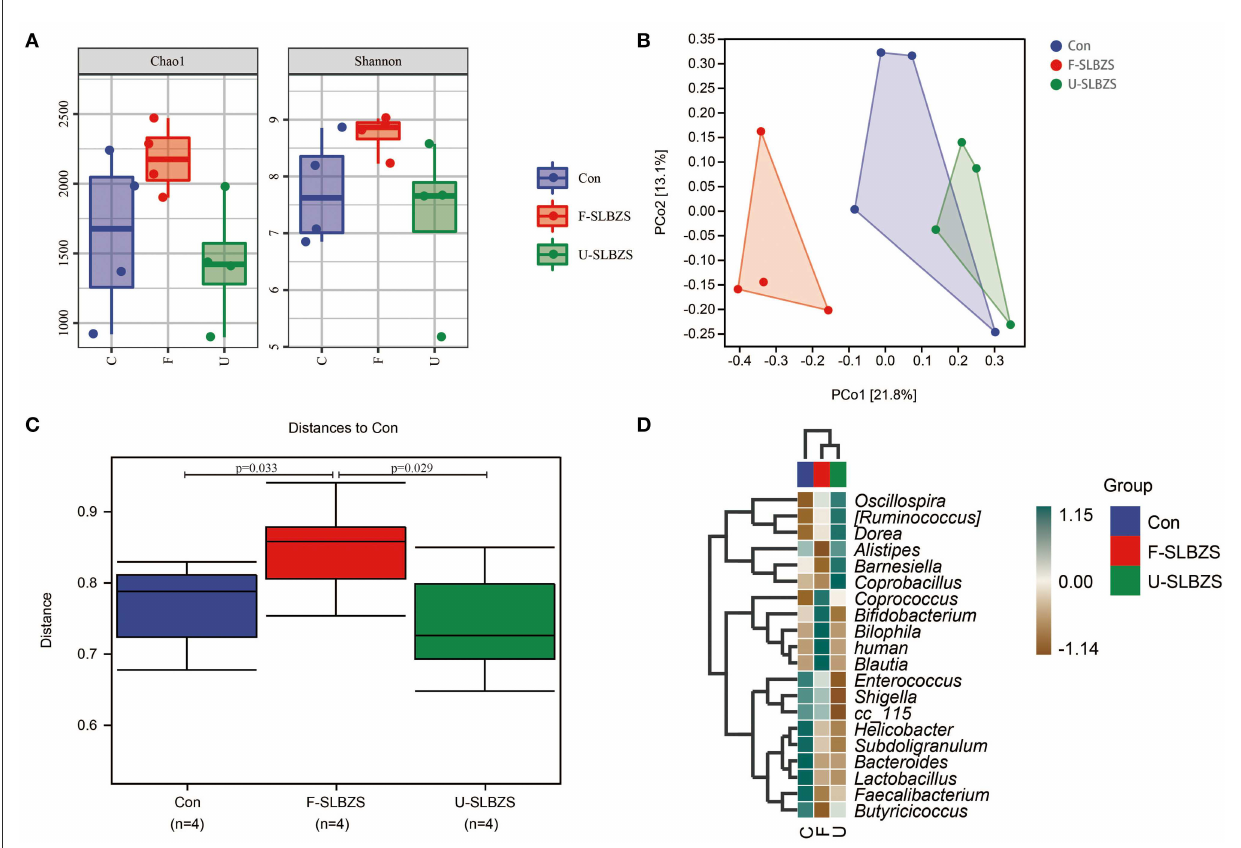
FIGURE7 Fermented alters the structure of the gut microbiota in broilers. (A) Alpha analysis, including Chao1 and Shannon. (B) Principal Co-ordinates Analysis (PCoA). (C) Between-groups difference analysis. (D) Heatmap of species composition.